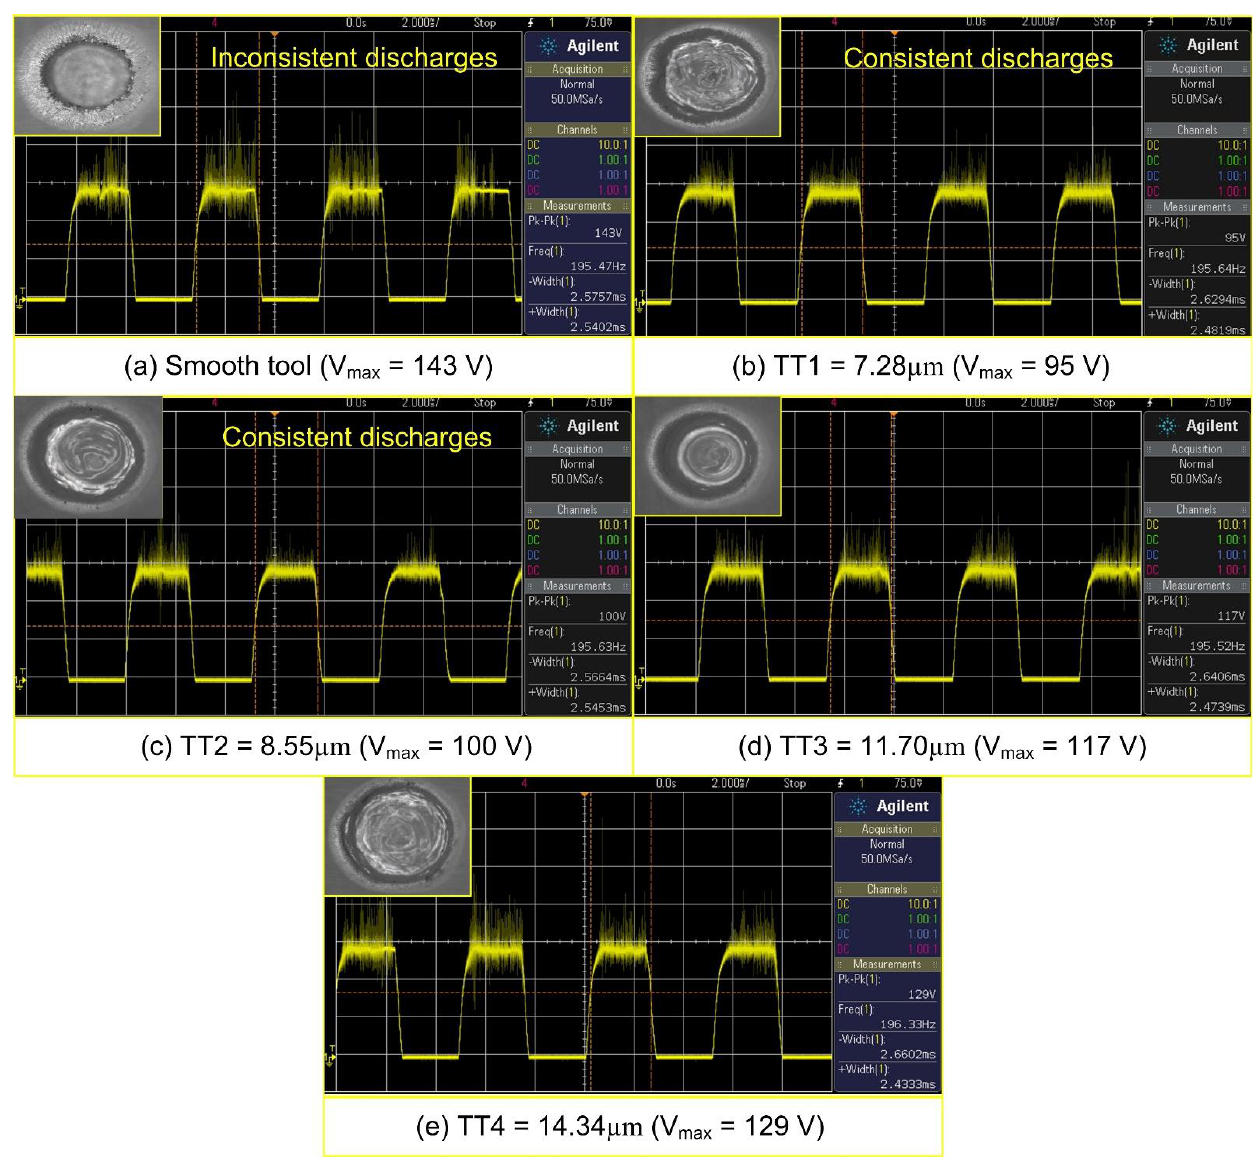
Figure 9. Effect of tool surface roughness on spark characteristics (Inset: machined micro holes). Beyond a surface roughness of 11.70 μ m (refer tool electrode TT 3), with an increase